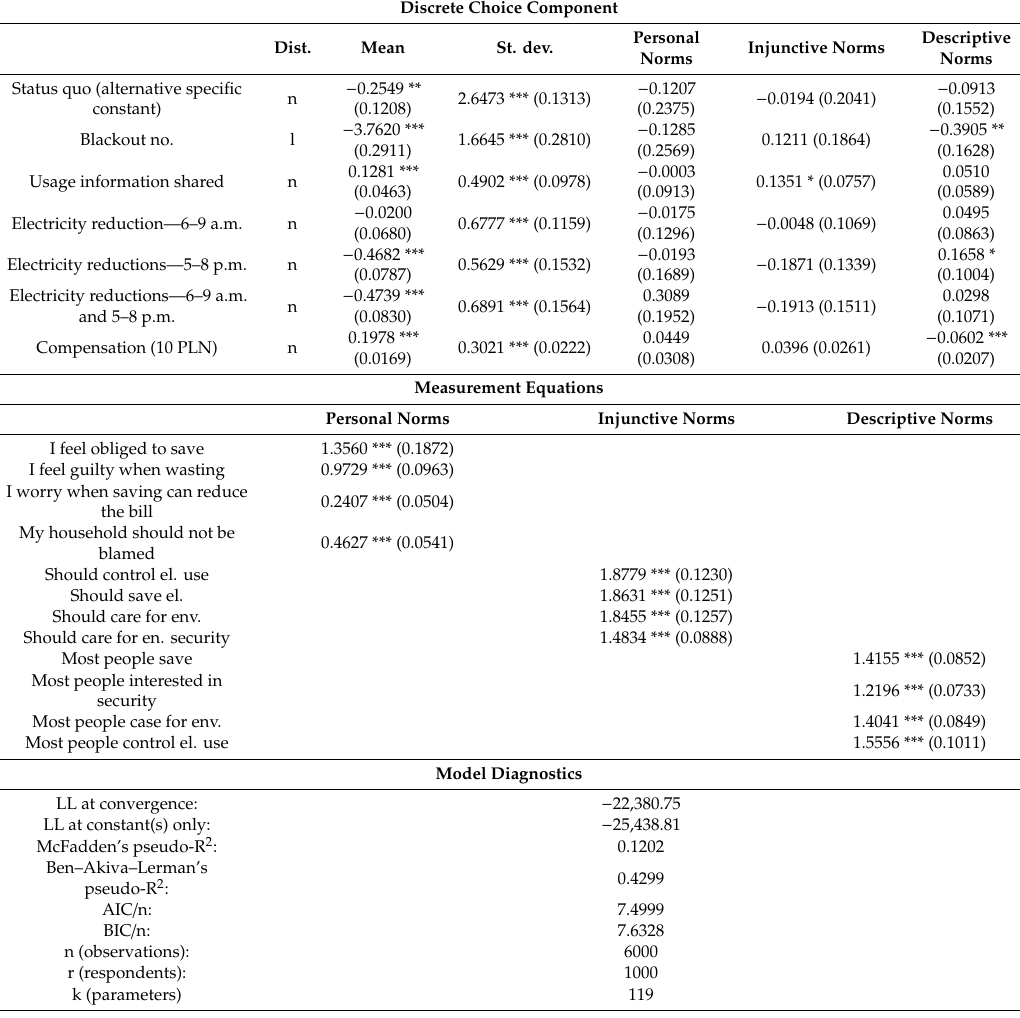
Table 5. The results of the hybrid choice model linking respondent social norms perceptions with their economic preferences for electricity supply